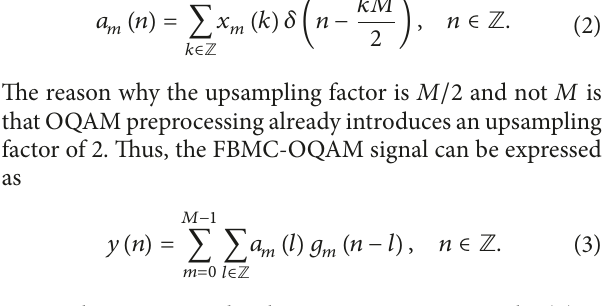
Figure 2: Block diagram of the OQAM symbols arrangement in a multicarrier system. For frequency domain alternation, one sample delay is applied to imaginary semisymbols in even subcarriers and to real semisymbols in odd subcarriers.